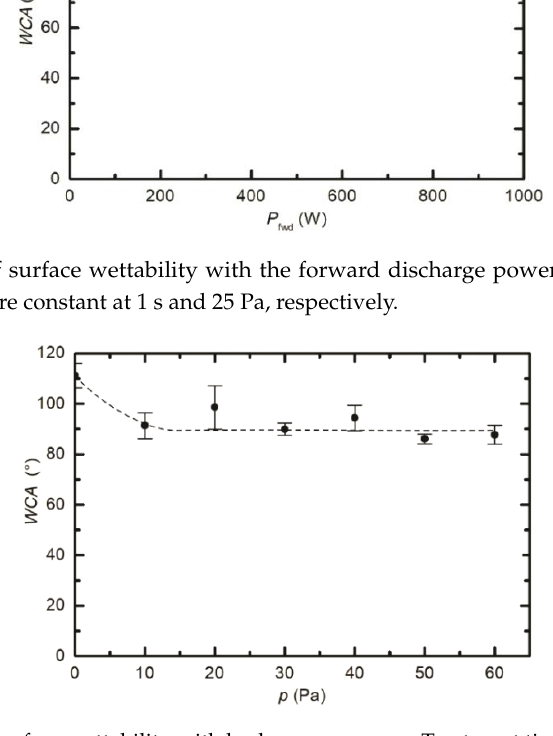
Figure 5. Variation of surface wettability with hydrogen pressure. Treatment time and discharge power were constant at 1 s and 400 W, respectively.